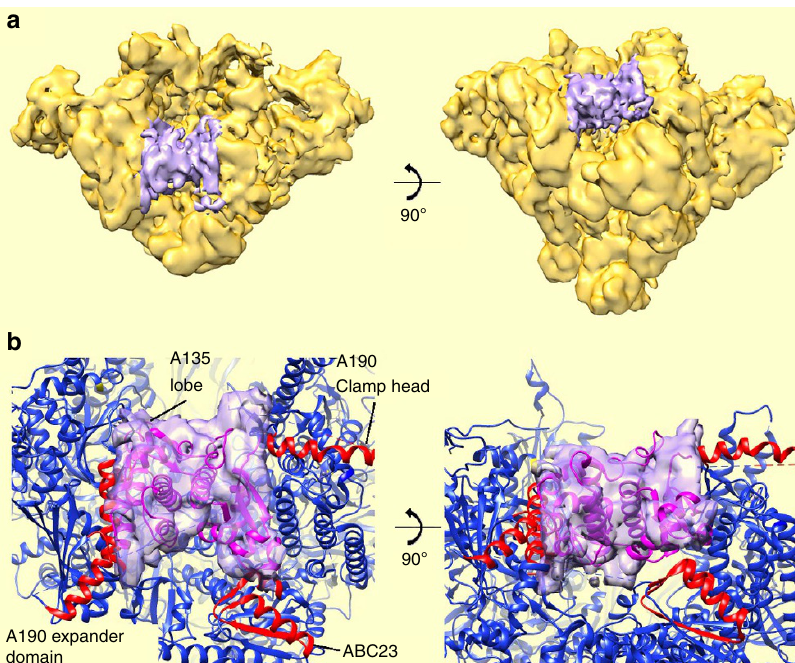
Figure 5 | The A49 tWD bridges the DNA-binding cleft. ( a ) Protein density (purple) found in a subpopulation of Pol I molecules. ( b ) Proposed fit of the A49 tWD (PBD accession number 3NFI (ref. 33)) within this density. Residues in contact with the A49 tWD are highlighted in red and correspond to the A190 clamp head domain (residues 256–303), the Pol I-specific regions flanking the A190 expander domain (1,320–1,337 and 1,440–1,456), a Pol I-specific region in the A135 lobe domain (residues 222–226) and the ABC23 subunit (residues